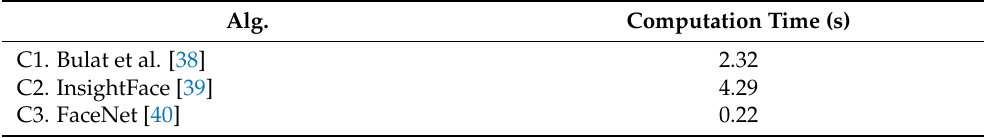
Table 3. Average computation time to process an image for the three candidates in all lighting